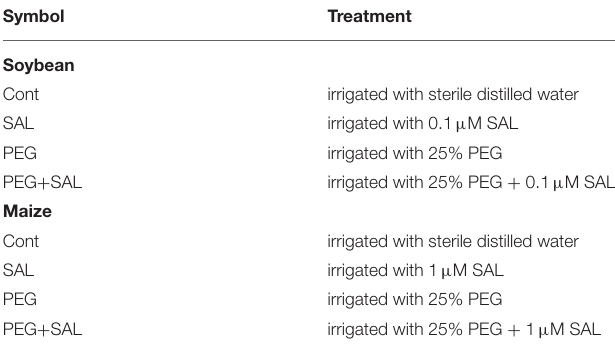
TABLE 1 | Experimental work